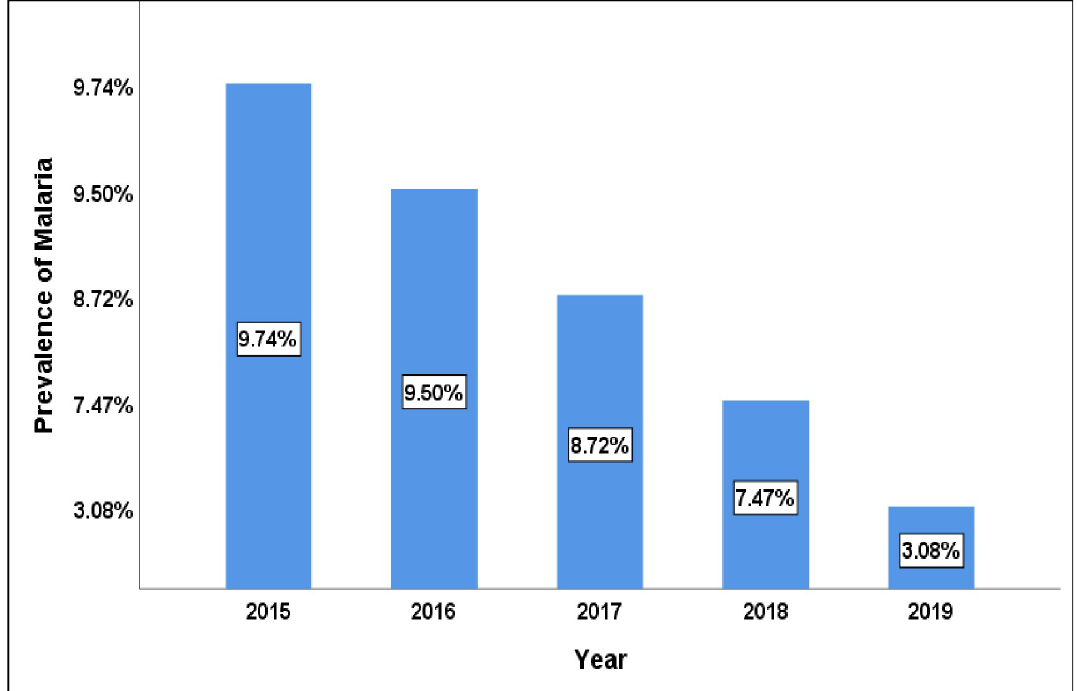
Fig 9. Trends in Malaria prevalence per 1,000 inhabitants in Nkongho-mbeng from 2015–2019.